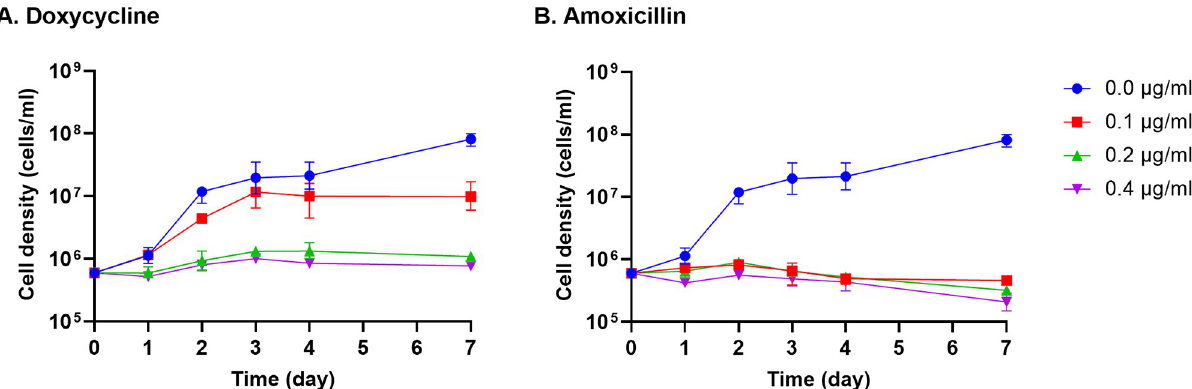
Fig 1. Effects of antibiotics on B . burgdorferi replication rates. (A) Doxycycline was added to freshly inoculated cultures at concentrations of 0.1 μ g/ mL, 0.2 μ g/mL, and 0.4 μ g/ml. (B) Amoxicillin was added to freshly inoculated cultures at concentrations 0.1 μ g/mL, 0.2 μ g/mL, and 0.4 μ g/ml. Bacterial numbers were determined by microscopical examination with a Petroff-Hauser counting chamber after 1, 2, 3, 4 and 7 days of culture.